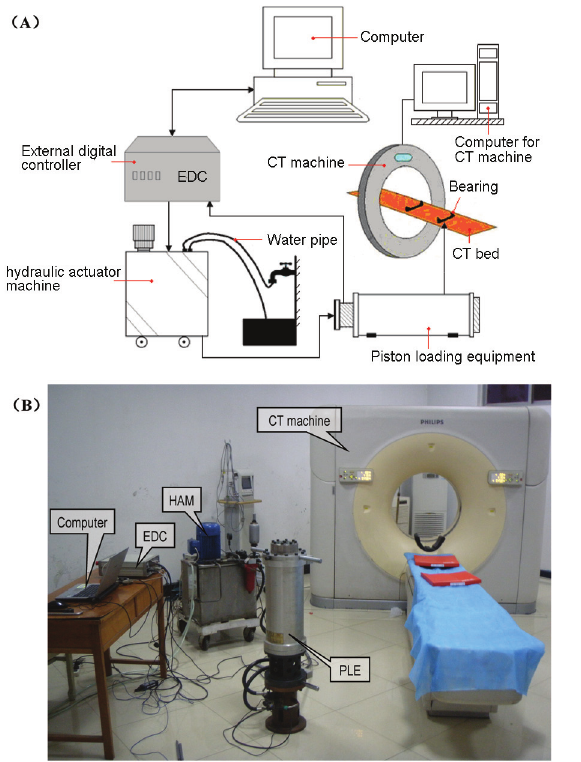
Fig. 3. Experimental setup: a) arrangement of testing instruments; b) photograph of the instrument layout